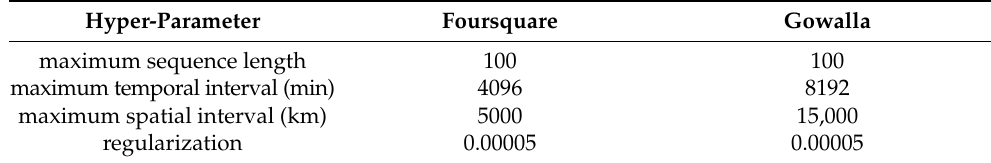
Table 4. Hyper-parameter settings on two datasets.